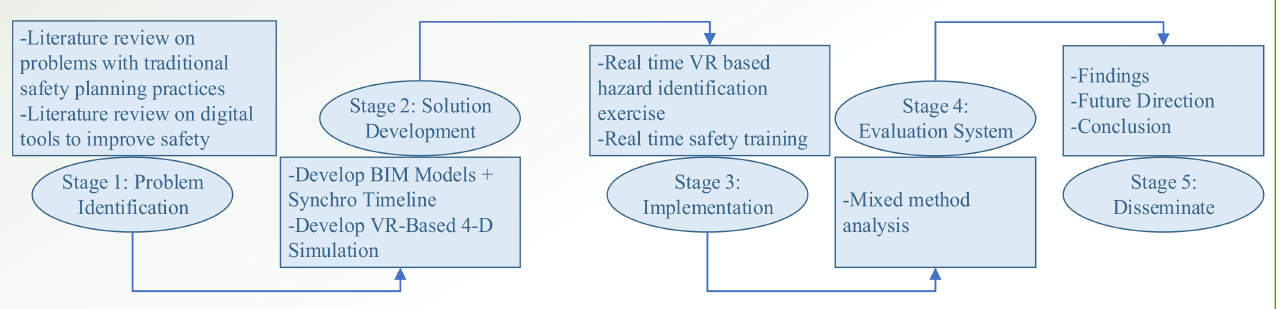
Figure 1. Research